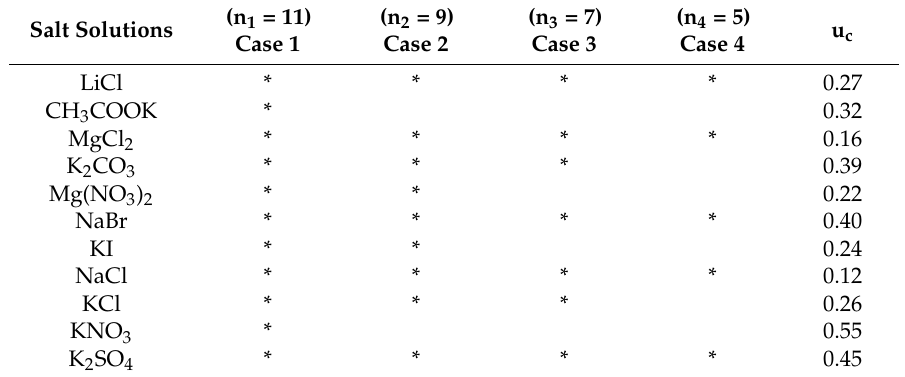
Table 3. The Calibration points for saturated salt solutions to establish the calibration